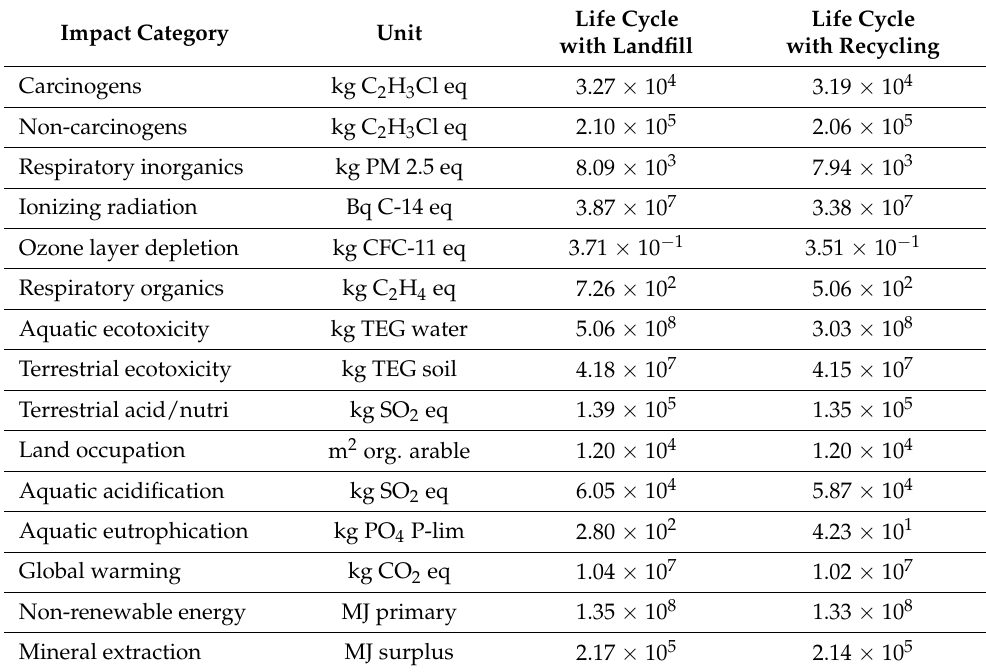
Table 2. The results of characterizing the environmental consequences in the life cycle of the research object by the form of post-use